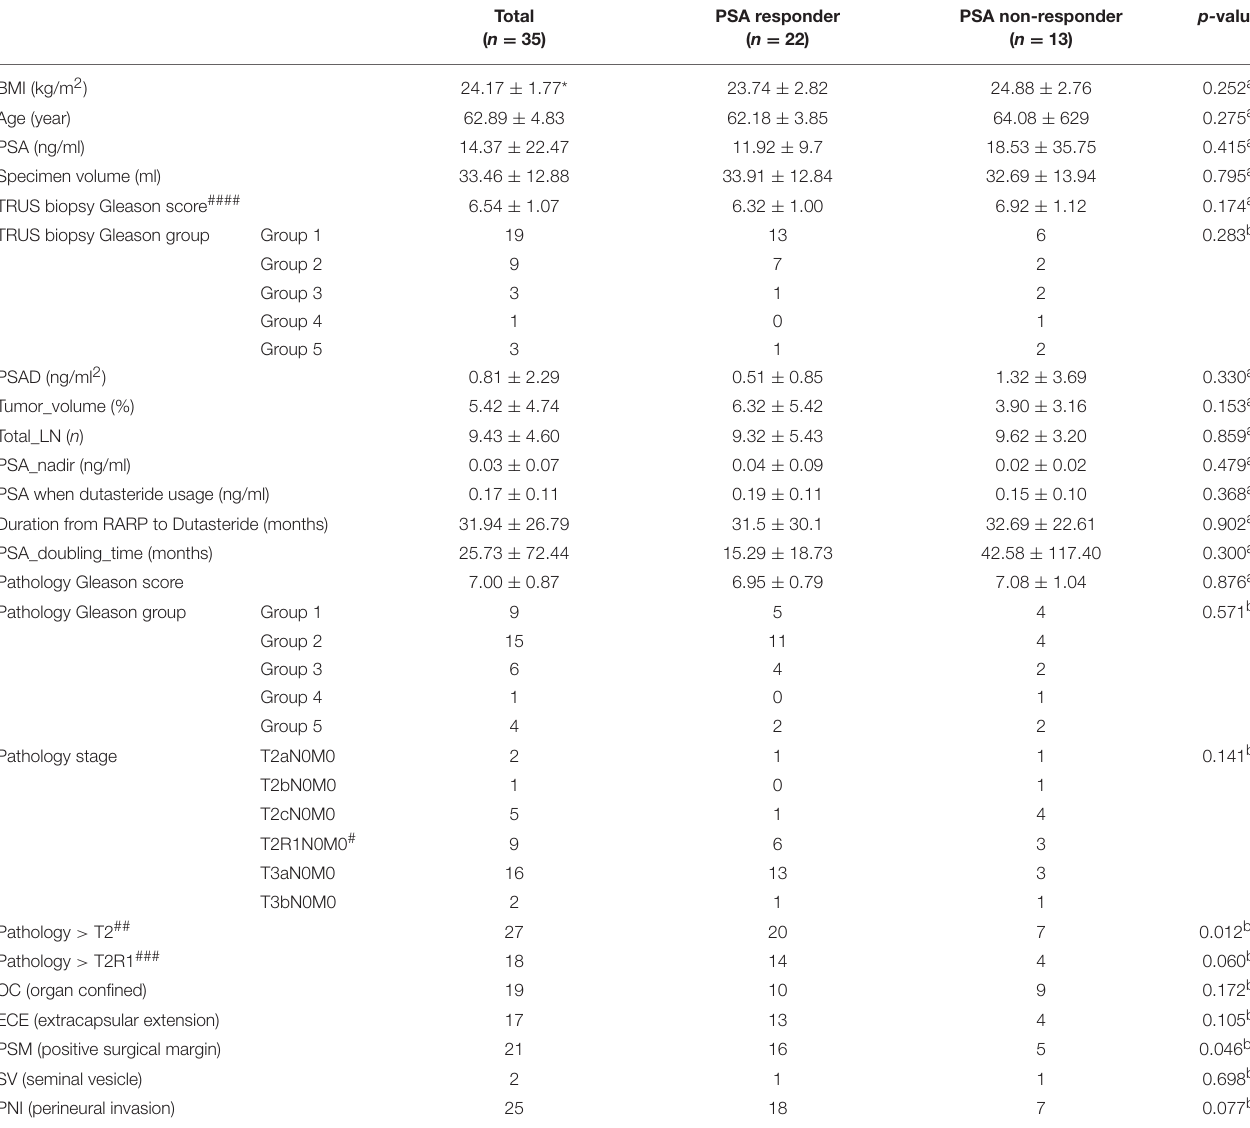
TABLE 1 | Comparison of clinicopathological variables between PSA responders vs.